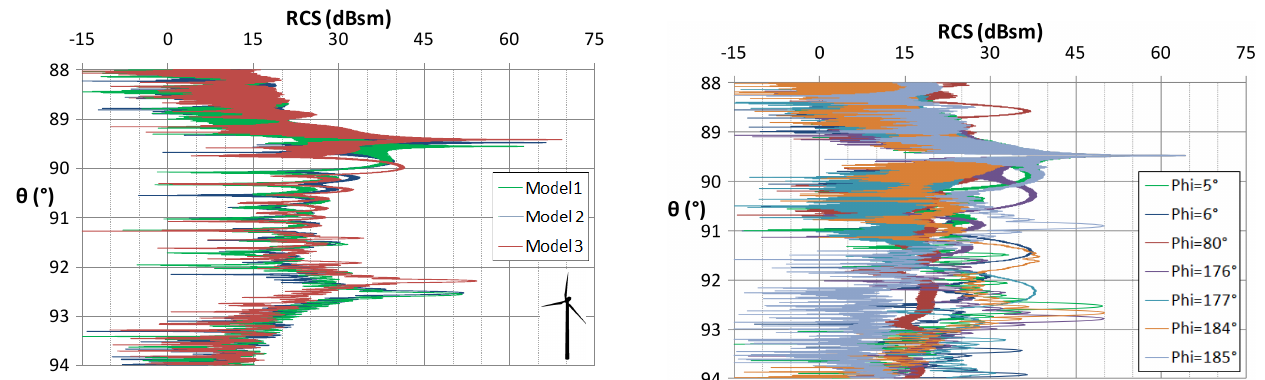
Figure 6. Vertical sections of RCS patterns ( φ = 5 ◦ , 6 , 80 , 176 , 177 , 184 , 185 ◦ ) for wind turbine model 2 at frequency 5.65 GHz and rotor position